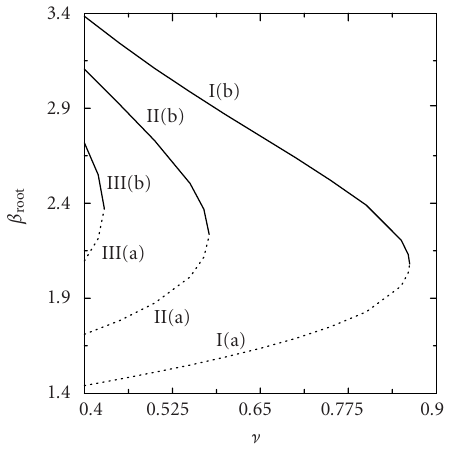
Figure 4.1. Two real roots of (4.3) in the text as a function of the nonintegrability parameter ν for three values of the parameter a . Since λ = 1, these states are unstaggered stationary localized states. Curves I(a) and I(b): a = 1 . 5, curves II(a) and II(b): a = 1 . 75, and curves III(a) and III(b) a = 2 . 0. While (a) or the lower part of all curves is for the smaller root β s , (b) or the upper part of these curves show the variation of the larger root β l . Note that this figure also shows the variation of ν critical as a function of the parameter a